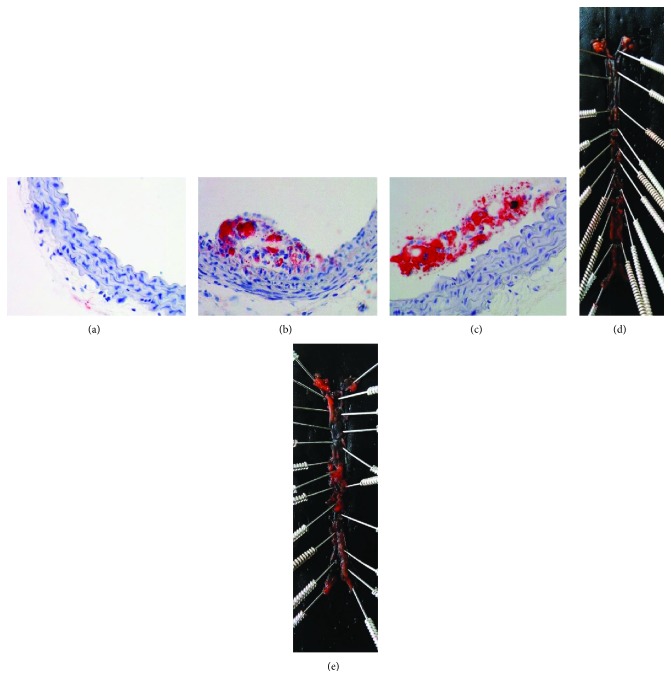
Aortic atherosclerotic plaques (Oil Red O staining). (a–c) Aortic atherosclerotic plaques in the ascending aorta: (a) Con group, (b) NC group, and (c) CIH group. (d, e) The longitudinal sections of the aorta in the NC and CIH group: (d) NC group and (e) CIH group.